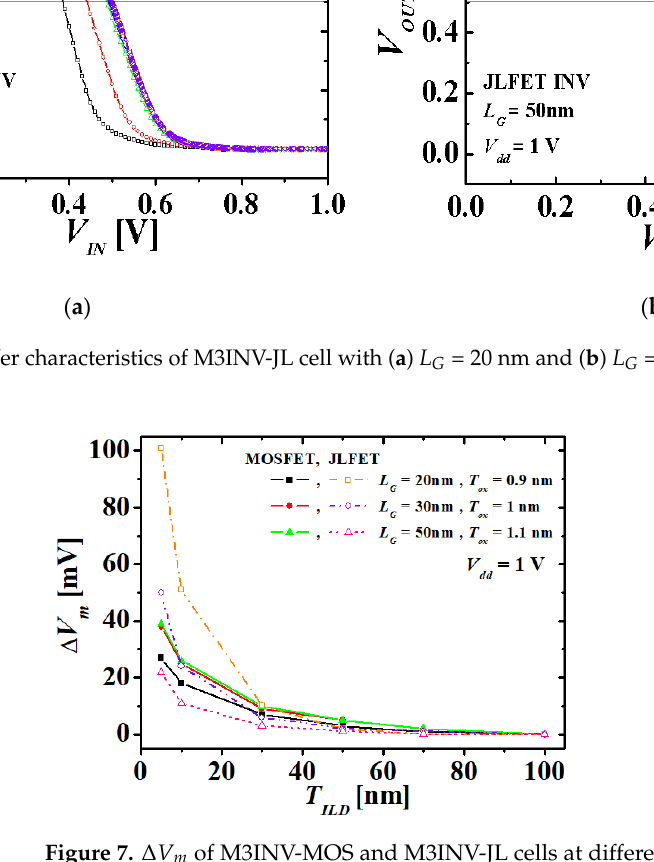
Figure 7. ∆ V m of M3INV-MOS and M3INV-JL cells at different channel lengths. Filled and empty symbols denote Δ V m of M3INV-MOS and M3INV-JL with T ILD = 5, 10, 50, and 100 nm, respectively. Figure 8 show the static noise margin (SNM) windows of M3INV-MOS and M3INV- JL with L G = 20 nm, respectively. The SNMs were measured as noise margin high (NM H ) and noise margin low (NM L ) extracted from VTCs of M3INV-MOS and M3INV-JL. Figure 9 shows the noise margins of M3INV-MOS and M3INV-JL at different L G s and T ILD s . In the case of M3INV-MOS, SNM increases as T ILD decreases. On the other hand, in the case of M3INV-JL, SNM decreases when T ILD decreases. When T ILD is over 30 nm, the maximum variations of SNM of both M3INV-MOS and M3INV-JL are below 20 mV, and thus the coupling in both structures can be also ignored. ( a ) ( b ) Figure 8. Static noise margin (SNM) characteristics of ( a ) M3INV-MOS cell and ( b ) M3INV-JL cell. Here L G = 20 nm and V dd = 1 V. Black, red, green, and blue lines denote the coupled voltage transfer characteristics (VTCs) of M3INV-MOS and M3INV-JL with T ILD = 5, 10, 50, and 100 nm, respectively.